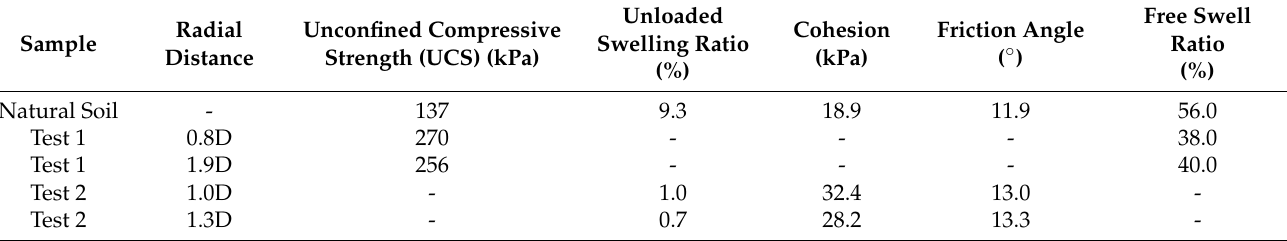
Table 10. Comparison of physicochemical and geotechnical behavior of tests 1 and 2 with natural samples. Sample